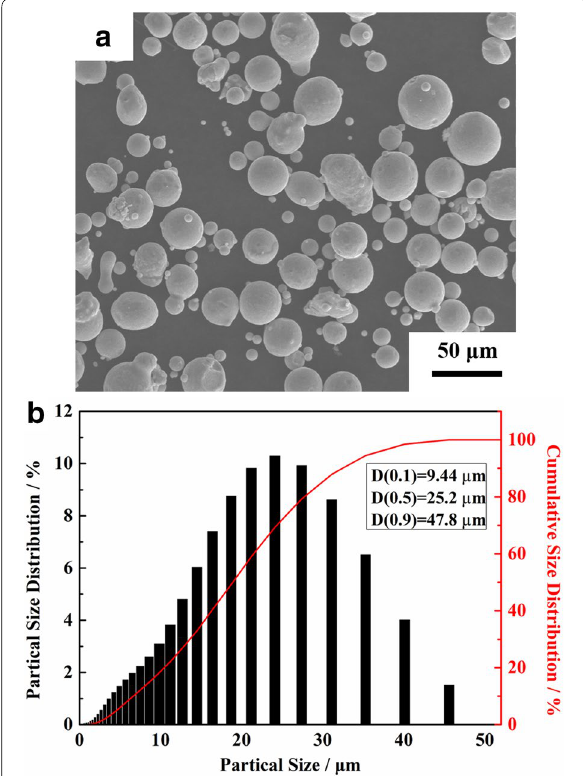
Figure 1 a SEM image showing the morphology of the S136 powder; b particle size